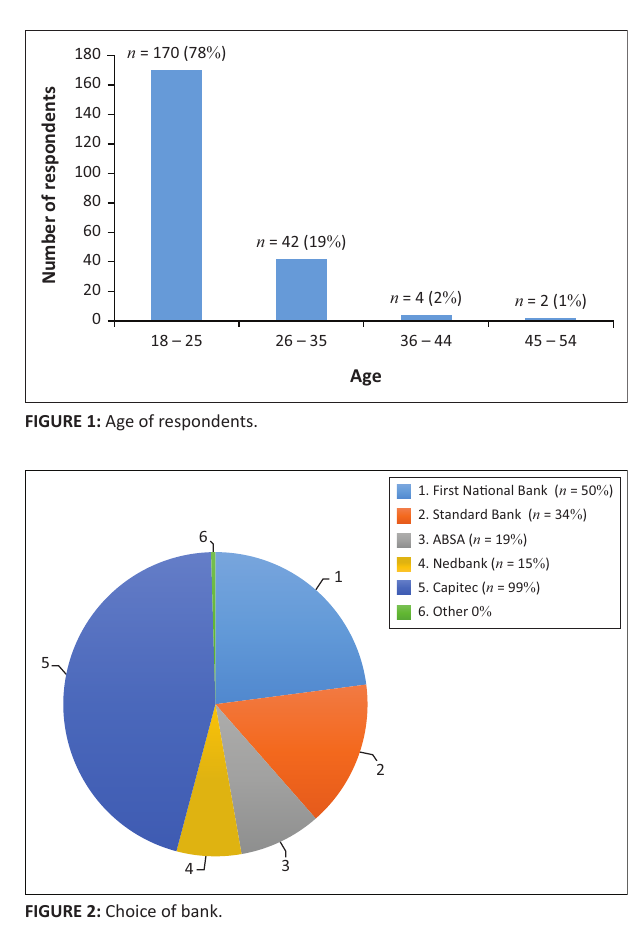
FIGURE 2: Choice of bank.